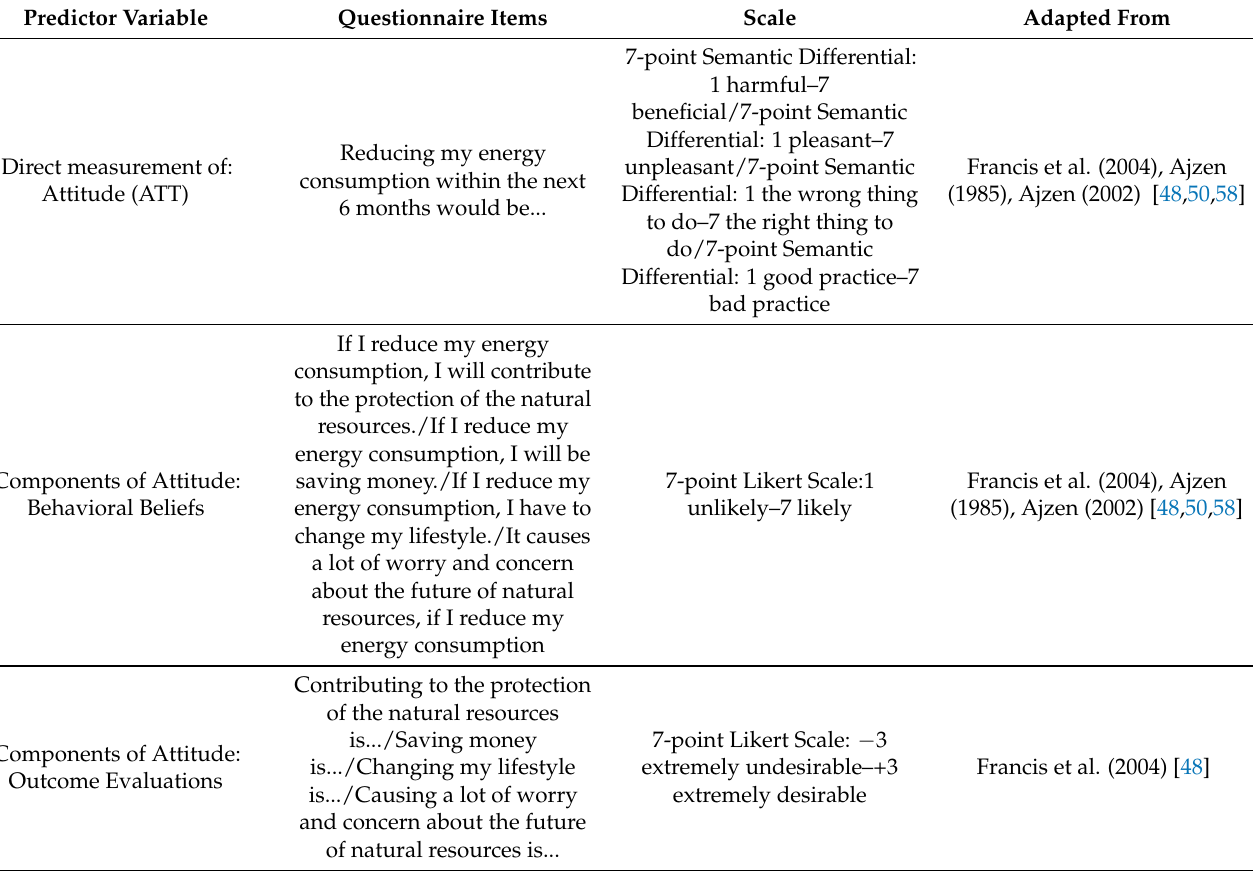
Table 2. Attitude (the table was created by using resource of Ajzen and Fishbein, 2005